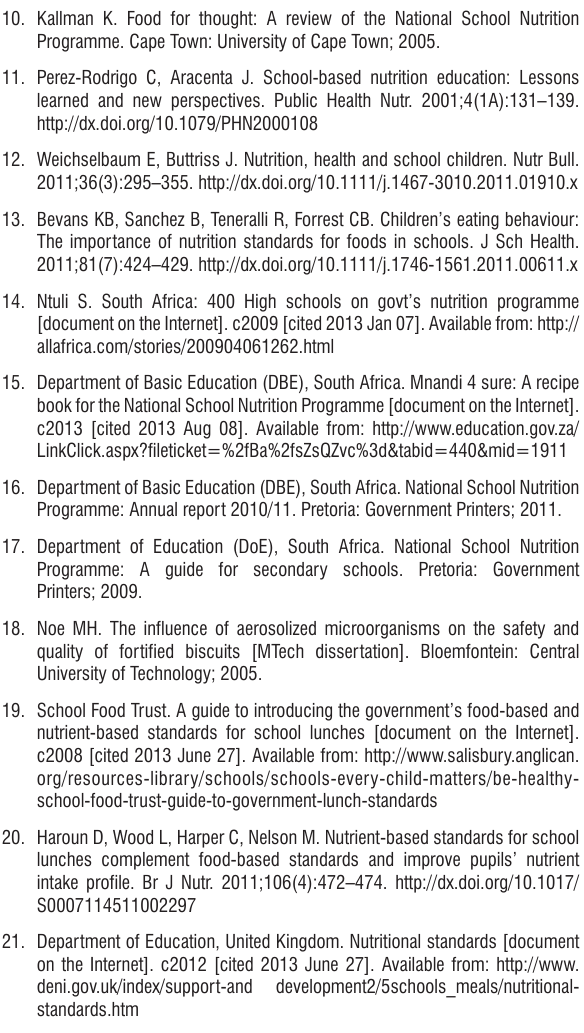
Figure 3: Relationship between moisture and vitamin C contents of meals served at various